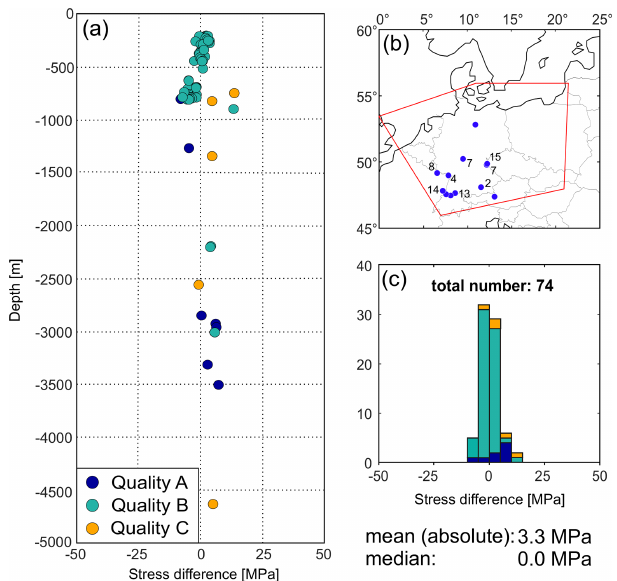
Figure 8. S hmin magnitudes of the model in comparison to the data of Morawietz and Reiter (2020). The differences are calculated as model results minus calibration data. (a) Depth depending differ- ences. Color of dots indicates the quality of the calibration data. (b) Spatial distribution of the calibration data used, numbers indi- cating localities with multiple data used. (c) Histogram of the differ- ences displayed in (a) . Coastlines and borders used in the figures are based on the Global Self-consistent Hierarchical High-resolution Geography (GSHHG) of Wessel and Smith (1996).